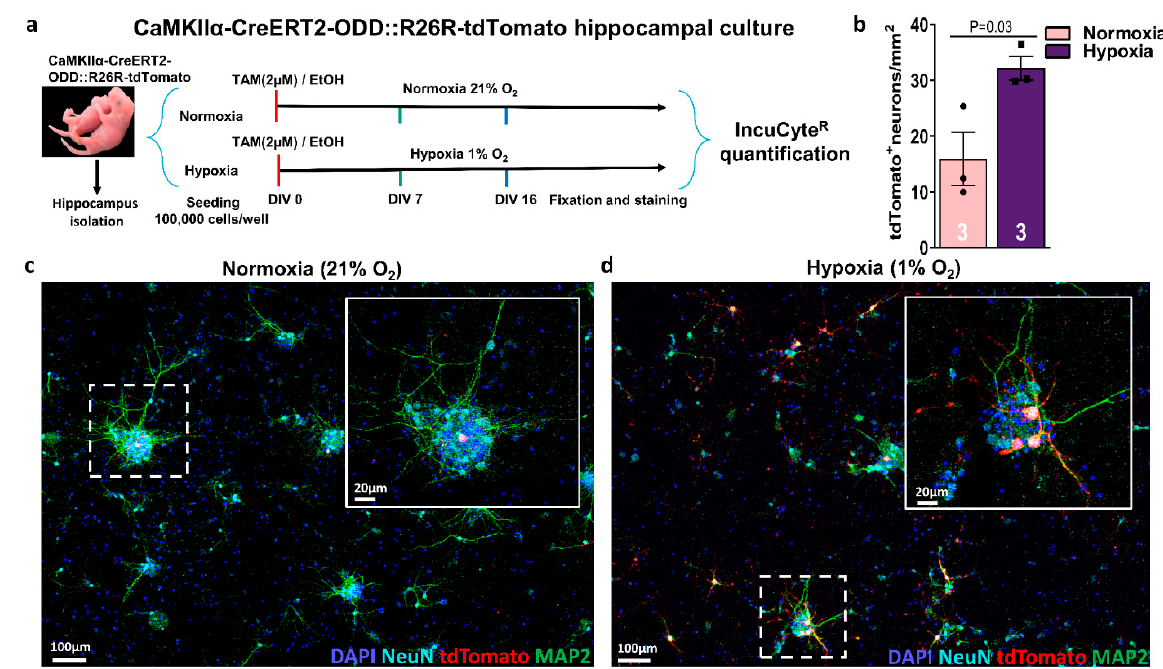
Figure 3. Maturing hippocampal neurons from CaMKII α -CreERT2-ODD::R26R-tdTomato mice respond to hypoxia also in vitro. ( a ) Experimental design: Isolation and culture of hippocampal neurons from E17 pups. (Z)-4-hydroxytamoxifen (2 µM) or solvent control (final EtOH concentration always <0.016%) are added to neuron cultures on day in vitro (DIV)0, followed by incubation in the IncuCyte R under either normoxia (21% O 2 ) or hypoxia (1% O 2 ) for seven or 16 days, fixation, staining, and quantification. ( b ) Quantification of hypoxic neurons, as visualized by tdTomato+ label, reveals an increase under hypoxia at DIV16. ( c , d ) Representative images of hippocampal neurons stained with neuronal markers NeuN (light blue), MAP2 (green) demonstrate co-localization with tdTomato (red), as shown strongly in hypoxic and less prominent in normoxic conditions. DAPI (blue) was used as a nuclear counterstain. Scale bars represent 100 µm in overview and 20 µm in magnified images. Unpaired Student’s t -test (one-tailed, Welch’s corrections) was used for statistical analysis between conditions; n numbers given in graphs; error bars indicate standard error of mean (SEM).